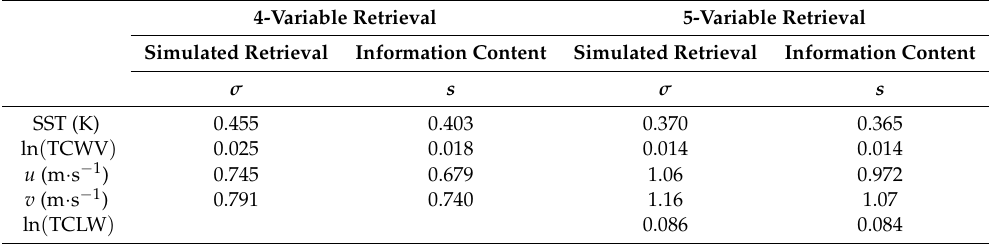
Table 2. The standard deviation of the retrieval error and root-mean-squared predicted uncertainties from an information content analysis across all profiles using the best channel combinations for simulated SST retrieval i.e., 10 channels for the 4-variable retrievals and all 14 channels for the 5-variable